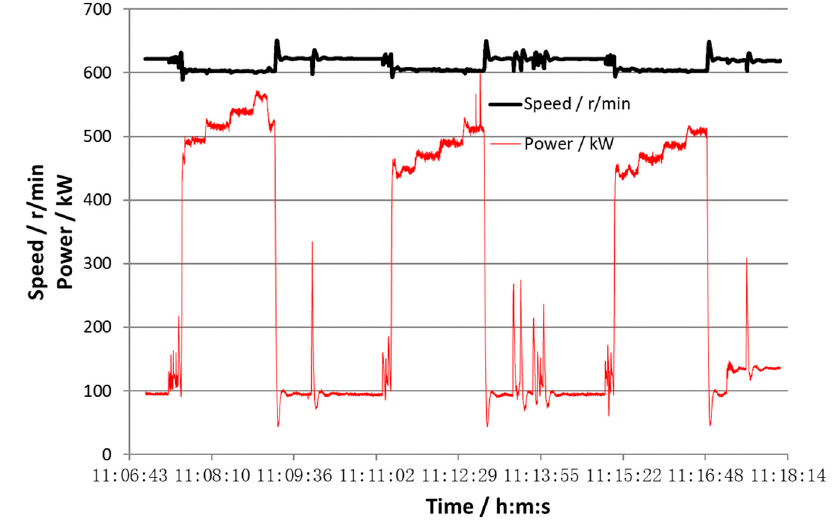
Figure 3. Operating mode of putting out of the hole.